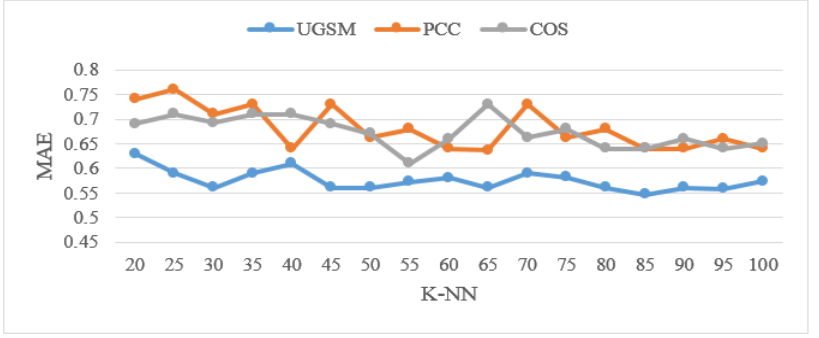
Figure 5. MAE for different k sizes on R2-yahoo music dataset by UGSM and other models. The x -axis is the K-NN size and the Y -axis is the MAE value. Table 9. MAE, NNf, and w min sim of adaptive R2-yahoo music